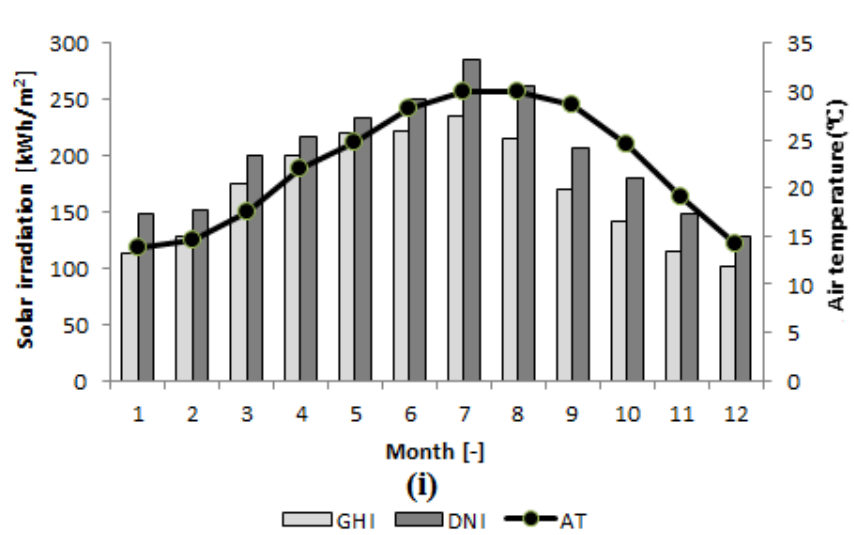
Figure 6. Mean monthly global horizontal irradiation, direct normal irradiation and air temperature for all selected regions in Libya; ( a ) Al bayda, ( b ) Al-kufrah, ( c ) Benghazi, ( d ) Darnah, ( e ) Espiaa, ( f ) Misratah, ( g ) Nalut, ( h ) Sabha, and ( i ) Tripoli. Table 7. Annual mean GHI, DNI, and AT for all selected regions. Table 8. Solar potential classification based on annual GHI and DNI [58].